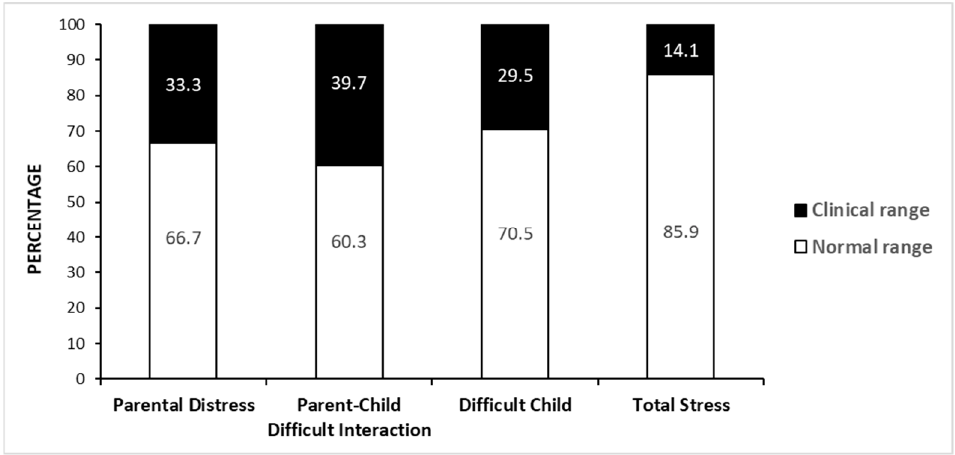
Figure 1. Distribution of the Parenting Stress Index scores